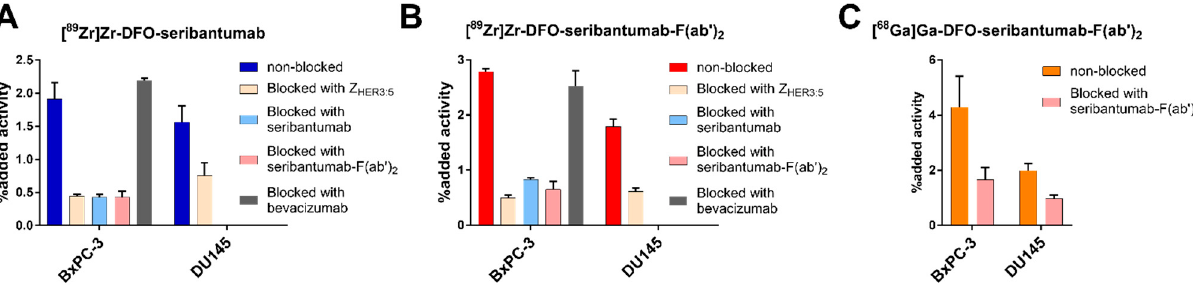
Figure 1. In vitro specificity of ( A ) [ 89 Zr]Zr-DFO-seribantumab, ( B ) [ 89 Zr]Zr-DFO-seribantumab-F(ab’) 2 , and ( C ) [ 68 Ga]Ga- DFO-seribantumab-F(ab’) 2 on BxPC-3 and DU145 cells. A blocking agent was added 15 min prior to the addition of the radiolabeled conjugates. The VEGFR-binding antibody bevacizumab was included as a non-HER3-blocking control. The in vitro specificity of [ 68 Ga]Ga-Z HER3 was published earlier and can be found in reference [27].